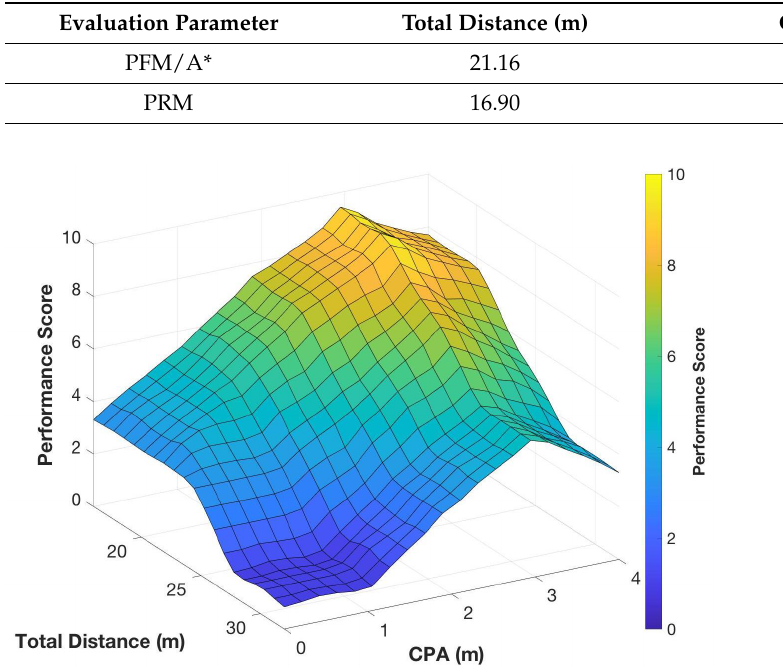
Figure 19. Case Study II 5-MF 3D plot relating the input variables (total distance and CPA) with corresponding output variables (performance